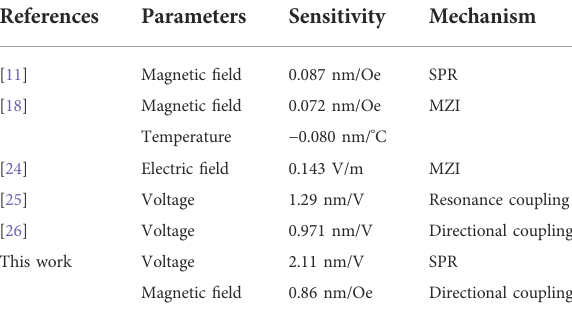
TABLE 1 Performance comparison of the proposed sensor with other recent reported PCF